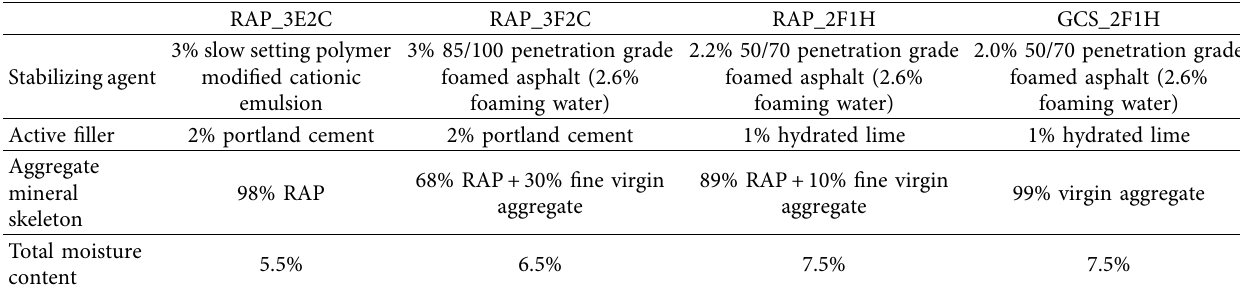
Figure 2: Scheme of recycled pavement sections. Table 1: Temperature and wildlife count in the three areas covered by the